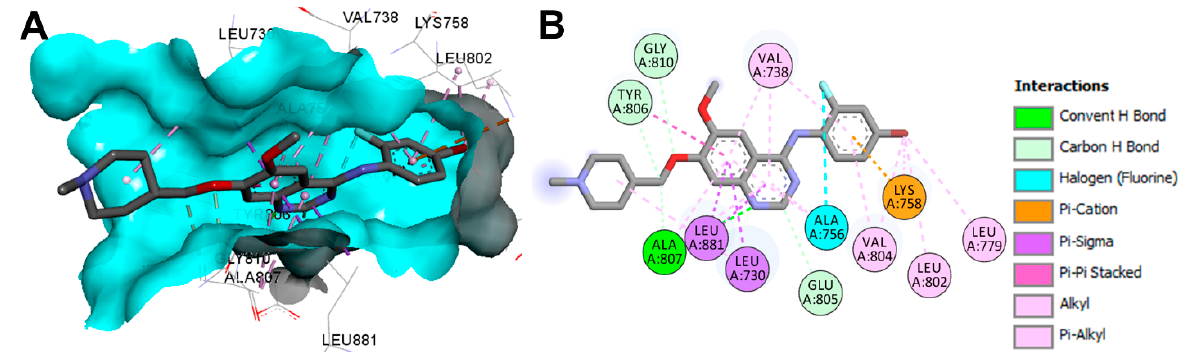
Figure 64. Two/three-dimensional binding mode of vandetanib (ZD6, pdb: 2IVU) bound to the phosphorylated RET tyrosine kinase domain: ( A ) 3D binding mode, receptor shown as hydrogen bond surface; ( B ) 2D binding mode of vandetanib showing different types of interaction with amino acids in RET; the figure was generated using Discovery Studio Visualizer (V16.1.0.15350).